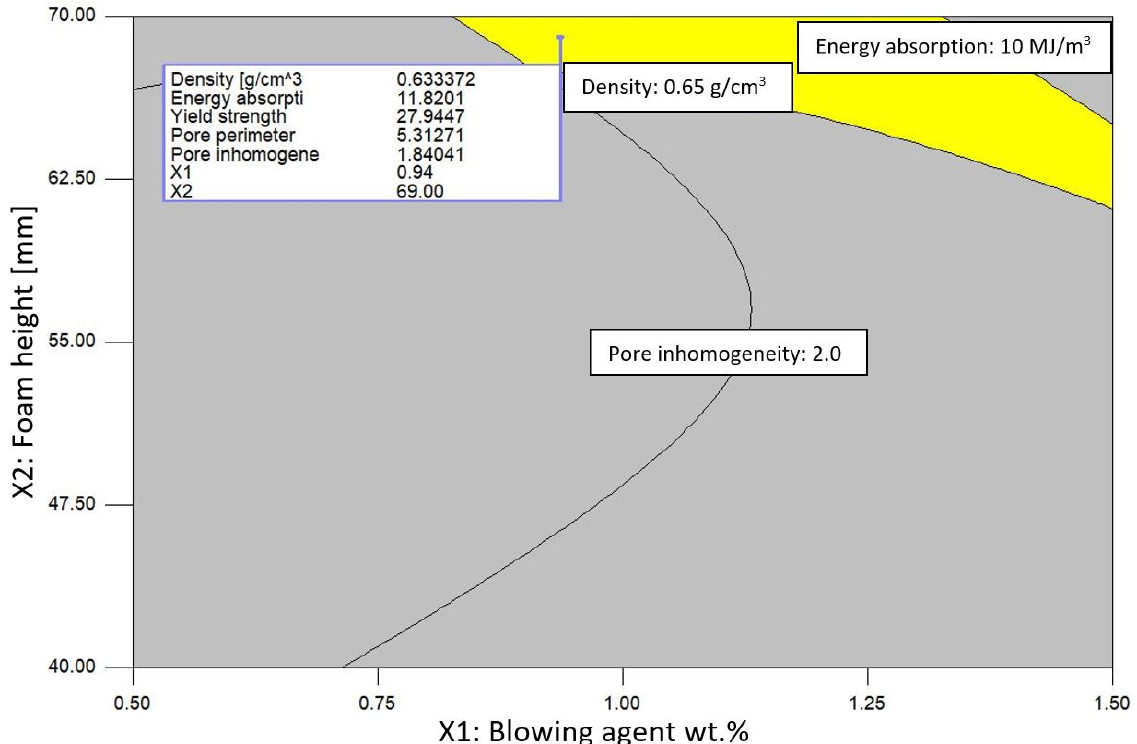
Figure 10. Graphical optimization of the process parameters for cost-effective metal foam production from machining chip waste.